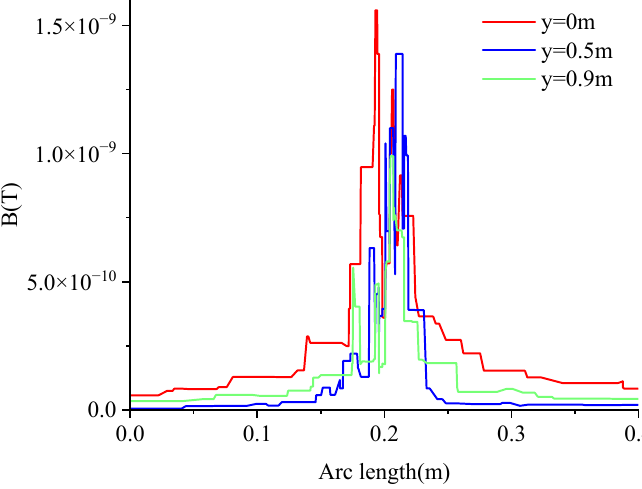
Figure 8. Variation curve of the magnetic field around the ground wire.